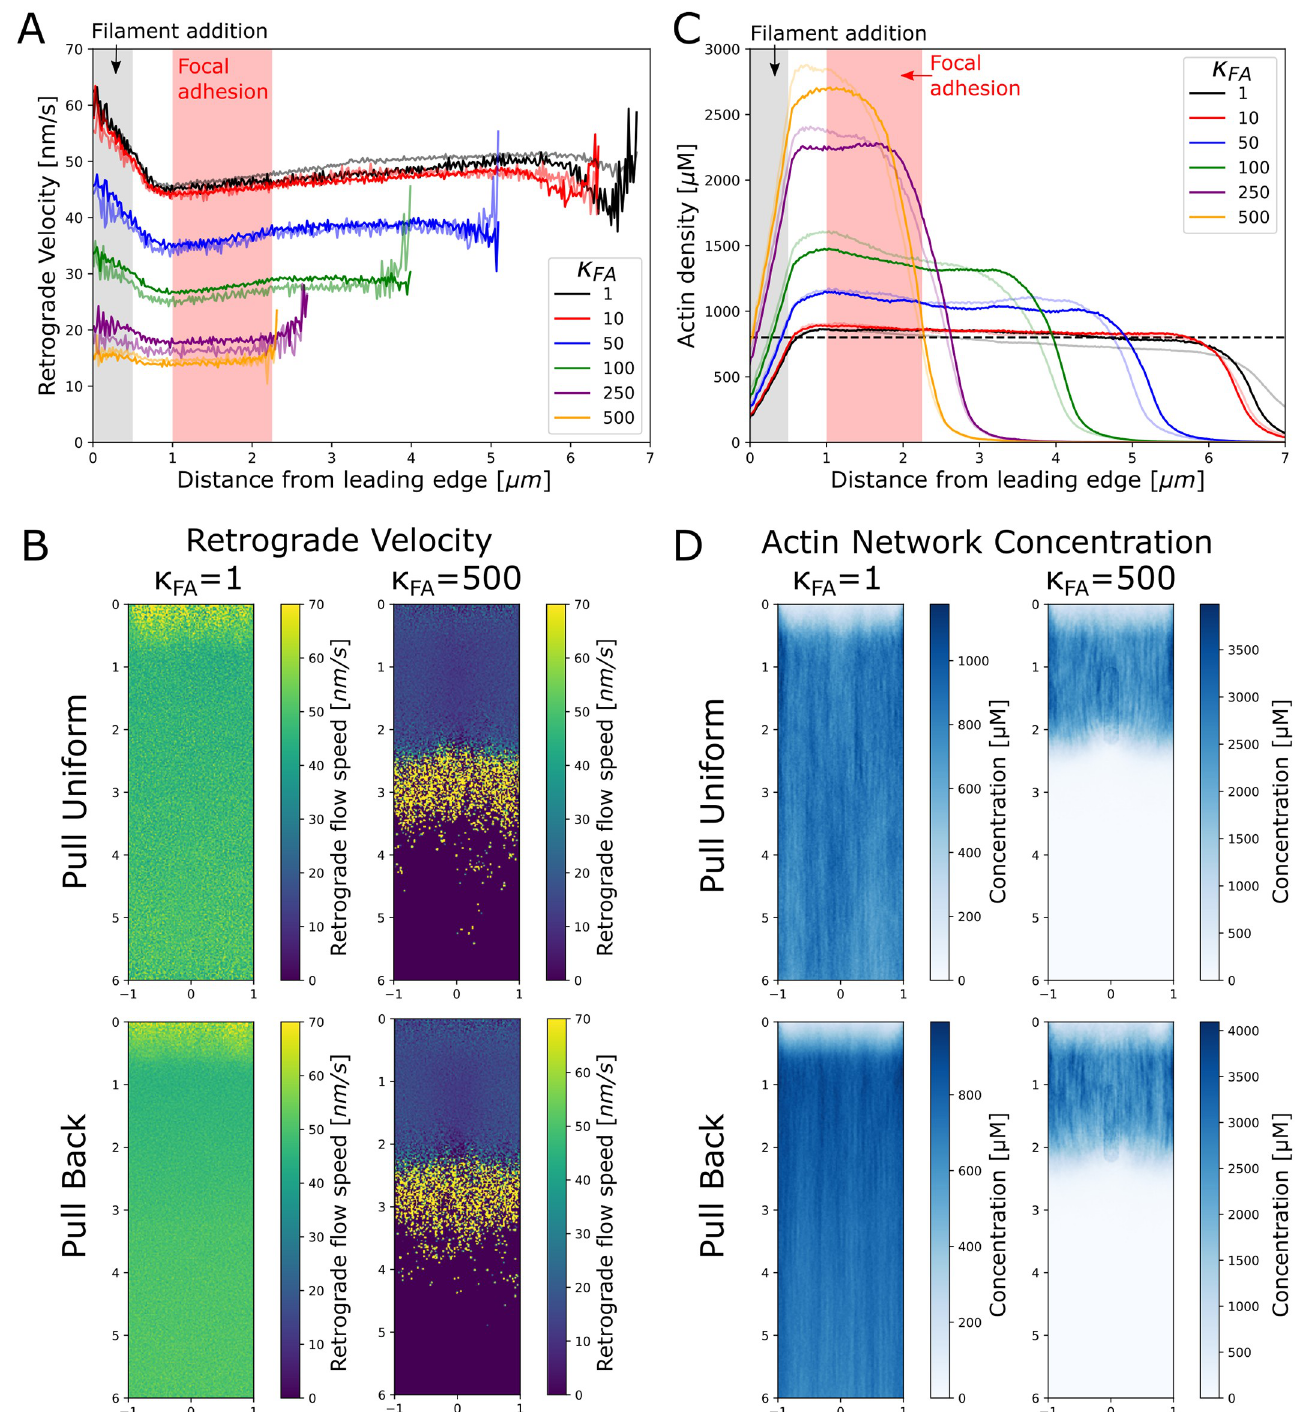
Fig 2. Strength of nascent focal adhesion region influences flow and concentration profiles. (A) Retrograde flow speed as a function of distance from leading edge ( y -position) shows that the retrograde flow velocities are highest near the leading edge (gray shaded region, where added filaments compact) and flattens between this region and the red shaded region which indicates the nascent focal adhesion region. Faded (solid) lines indicate pull back (pull uniform) simulations. (B) Time-averaged retrograde flow velocity profiles are largely uniform regardless of the pull mode (uniform vs. back) with slightly higher retrograde flow speeds at the front and towards the back. (C) Actin network density as a function of distance from leading edge ( y -position) where faded (solid) lines indicate pull back (pull uniform) mode. The actin network plateaus outside of the filament addition region (gray region), while focal adhesion strength determines the height of the